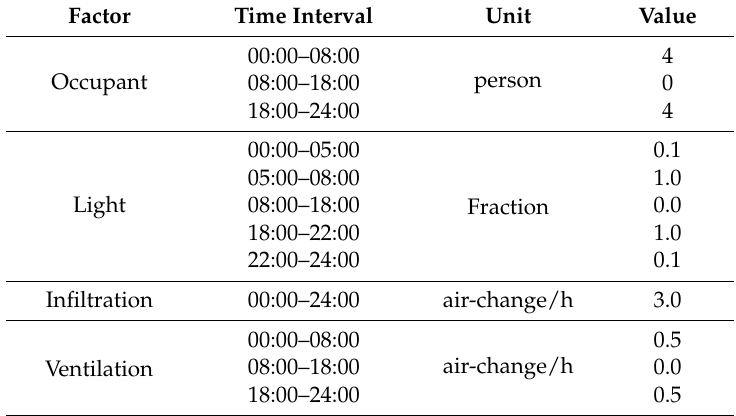
Table 6. Schedules of daily occupants, light, infiltration, and